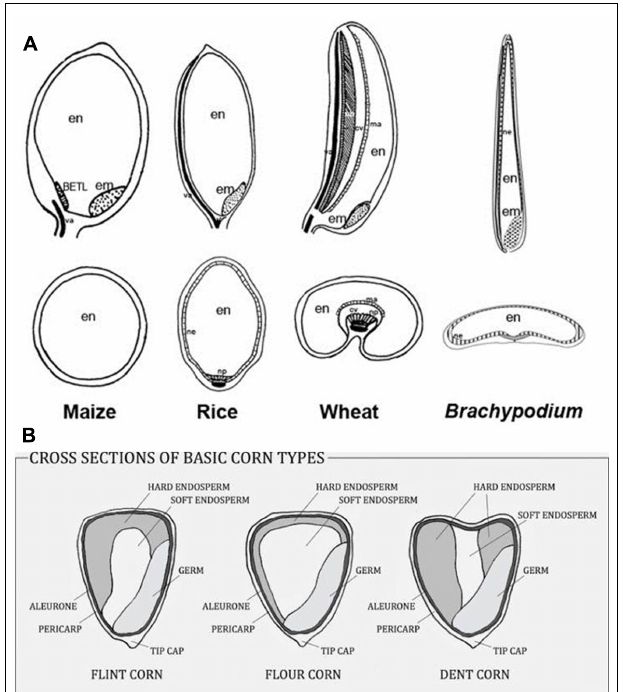
FIGURE 1 | (A) Examples of different grain morphologies. (B) Hard and soft endosperm proportions vary in maize kernels. Reproduced with permission from Hands and Drea (2012) and http://www.deductiveseasoning.com/ 2014/03/planting-and-growing-corn-for-nutrition.html. In panel (A) , em, embryo; en, endosperm; ma, modified aleurone; cav, cavity; va, vasculature; ne, nucellar epidermis; np, nucellar projection; BETL, basal endosperm transfer layer.